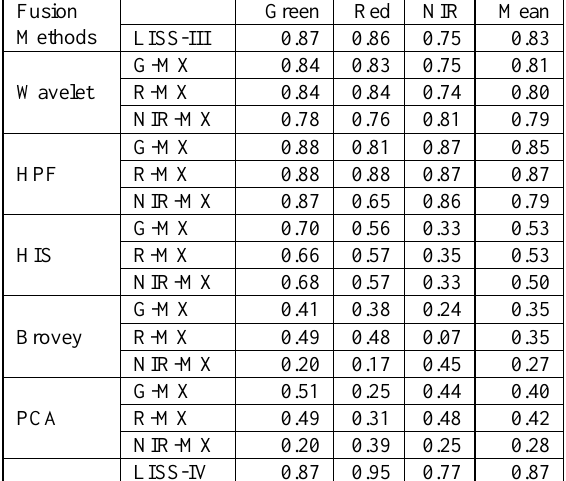
Table-3: Q index for different fusion